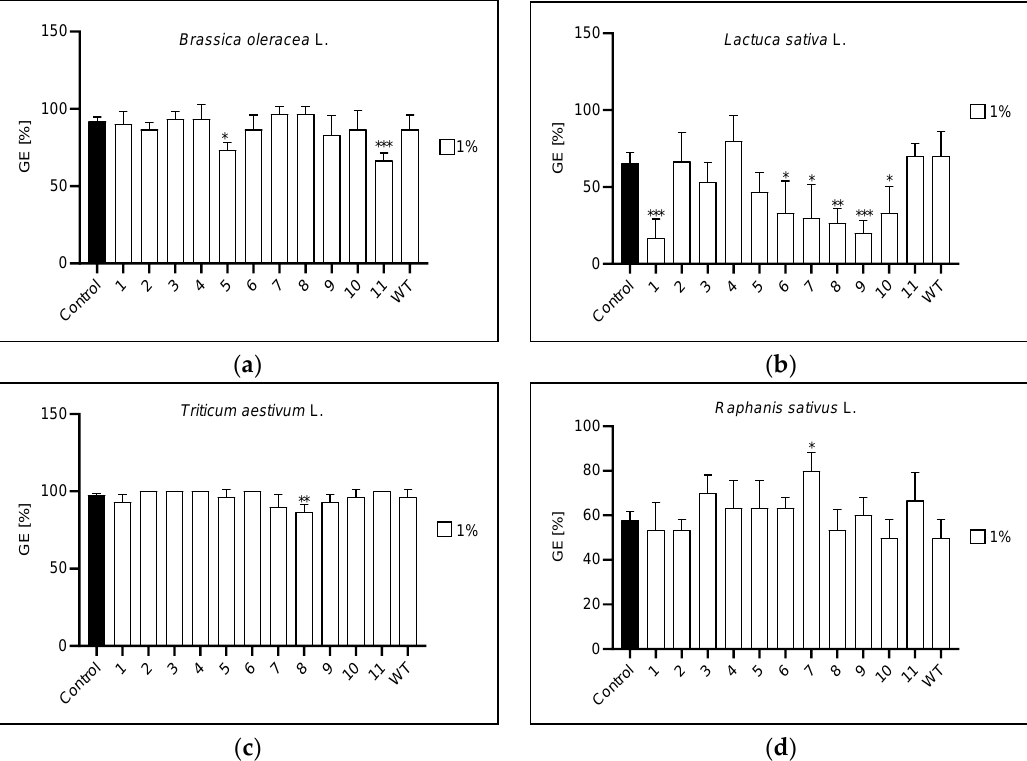
Figure 2. Percentage of germination of broccoli ( a ), lettuce ( b ), wheat ( c ), and radish ( d ) seeds treated with 1% concentration for all algae clones tested (1-11, WT) and control (Control). Values represent mean ± SD, n = 10 plants, * p < 0.1, ** p < 0.01, *** p < 0.001 compared to control (ANOVA and Dunnett’s a posteriori test).